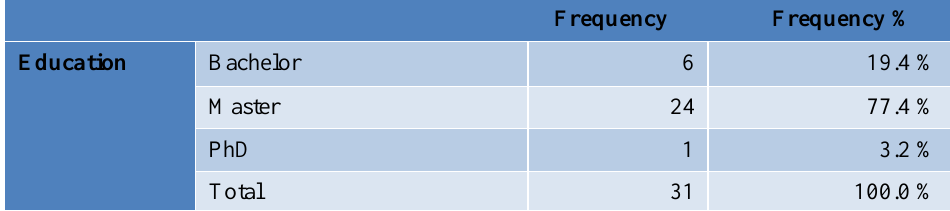
Table 2. Characteristics of respondents [Table made by